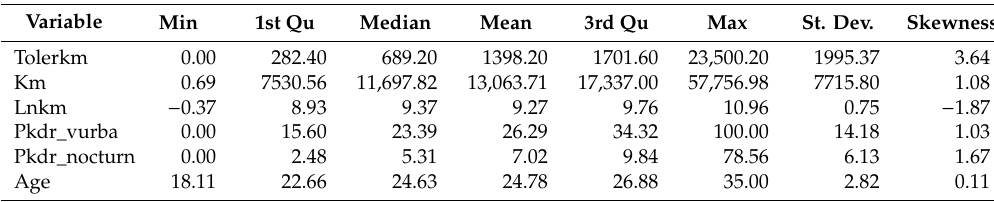
Table 2. Descriptive